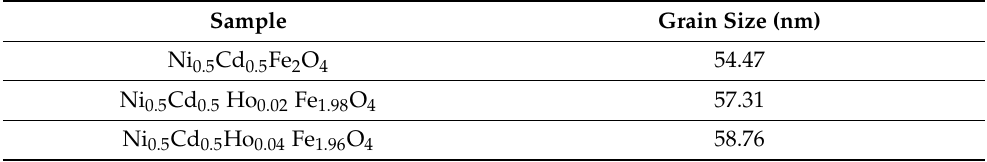
Figure 2. The SEM micrographs of all the samples of Ni 0.5 Cd 0.5 Ho x Fe 2-x O 4 (x = 0, 0.02, and 0.04). ( a ) X = 0; ( b ) X = 0.02; ( c ) X = 0.04.; and ( d ) EDX spectrum. Table 2. Grain size obtained from SEM analysis for Ni 0.5 Cd 0.5 Ho x Fe 2-x O 4 (x = 0, 0.02, and 0.04) nanoparticles.